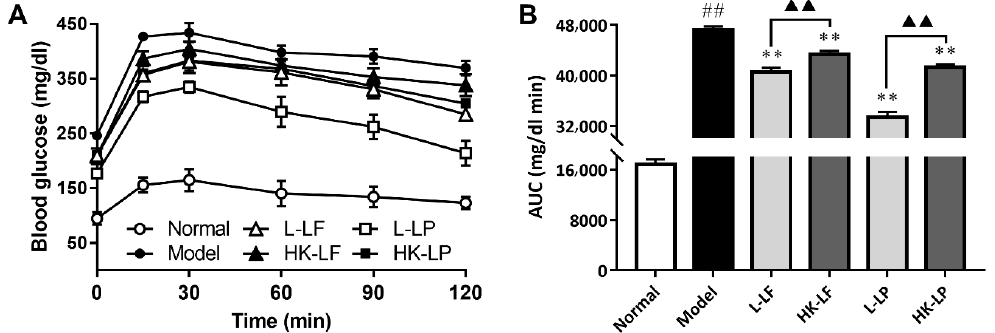
Figure 5. Differences in oral glucose tolerance. ( A ) The levels of oral glucose tolerance, ( B ) AUC value which represented the area under the curve of glucose level .L-LF: live LF group; HK-LF: heat-killed LF group; L-LP: live LP group; HK-LP: heat-killed LP group. ## P < 0.01 compared with Normal, ** P < 0.01 compared with Model, and ▲▲ P < 0.01.